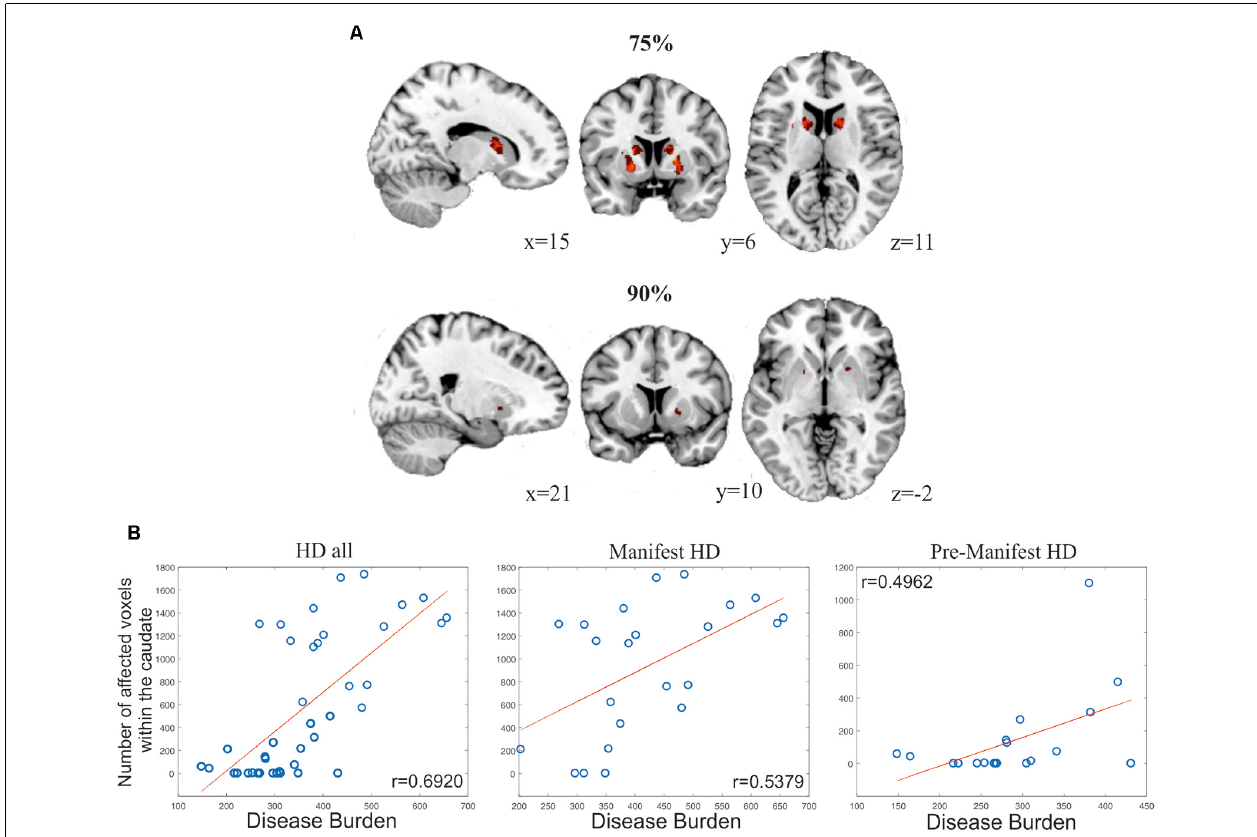
FIGURE 8 | Results from analyses evaluating the global power of SeSBAT for identifying signs of neurodegeneration. (A) Overlay of voxels with atrophy that is consistent across 75% (upper panel) and 90% (lower panel) of manifest HD patients. Reported coordinates are MNI coordinates. (B) Association between the number of affected voxels within the caudate and disease progression in all HD (left), manifest HD (center), and pre-manifest HD (right) patients. Pearson’s correlation coefficients (r) were